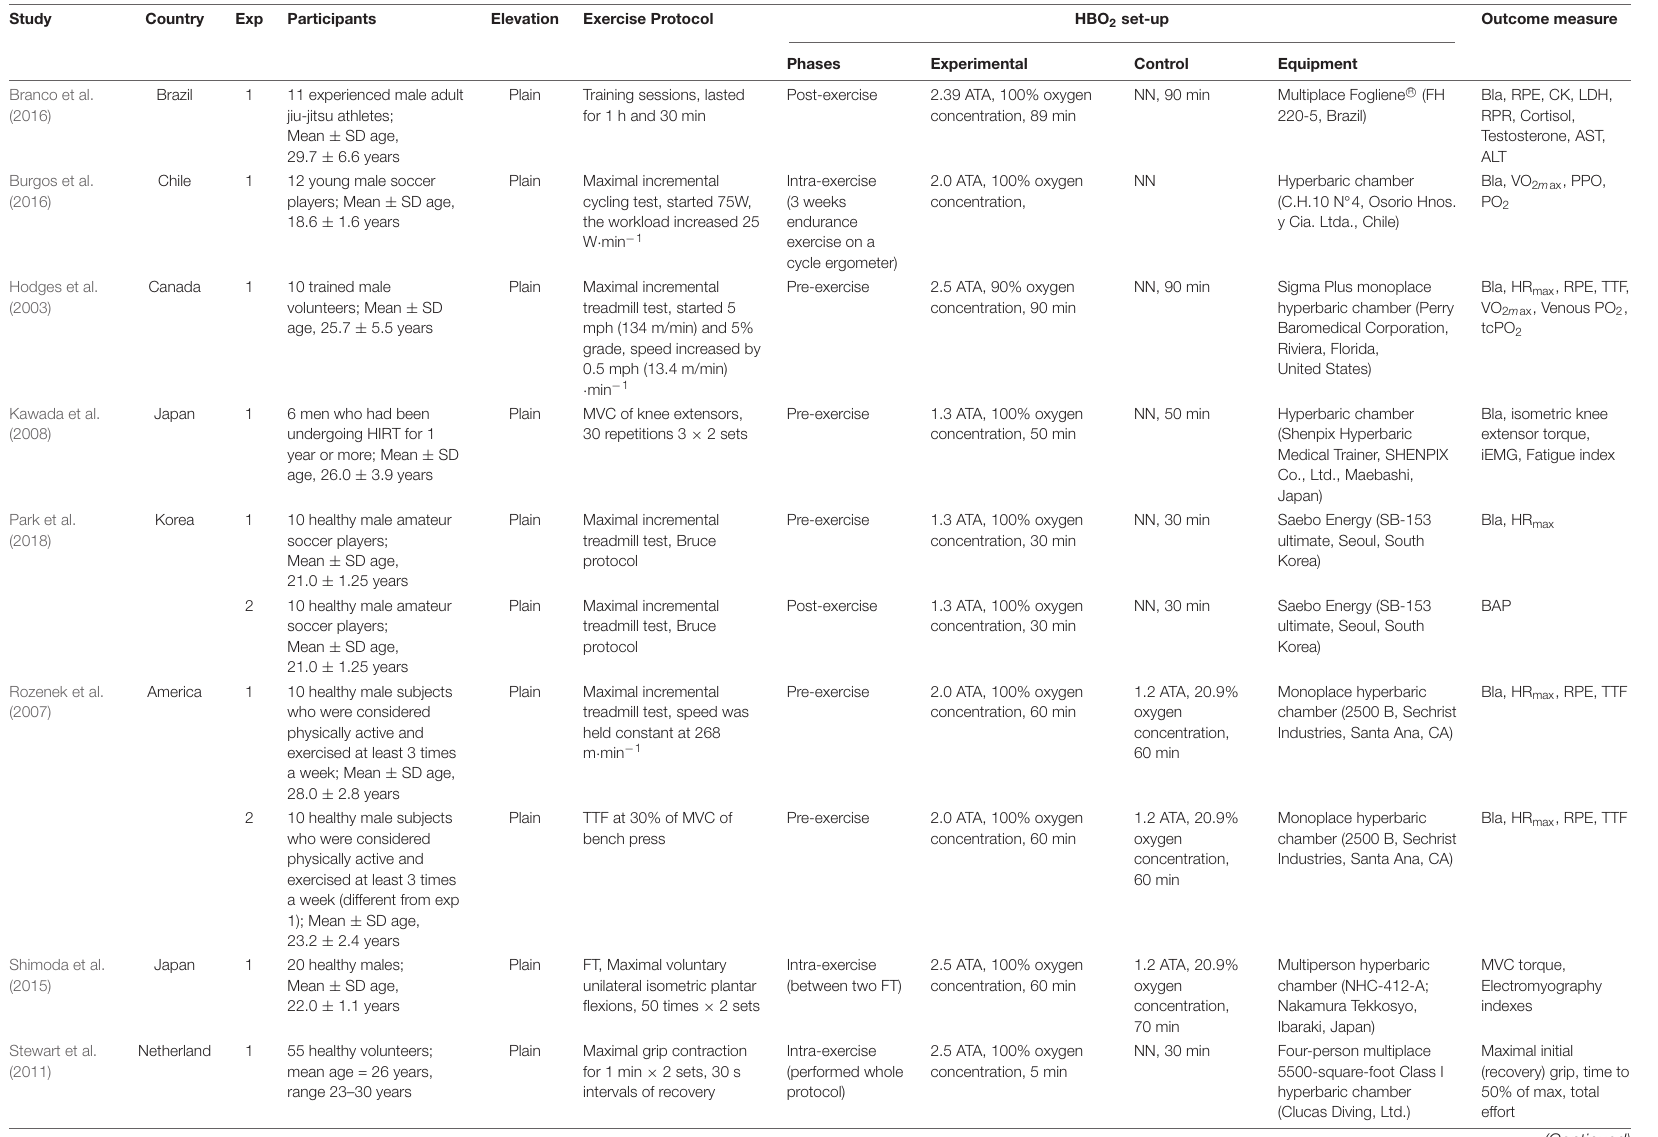
TABLE 1 | Characteristics of the included